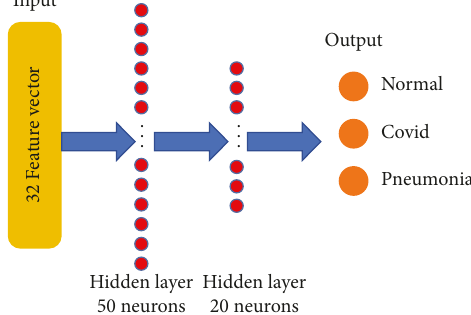
Figure 3: Employed multilayer neural network for the 3-set classification.